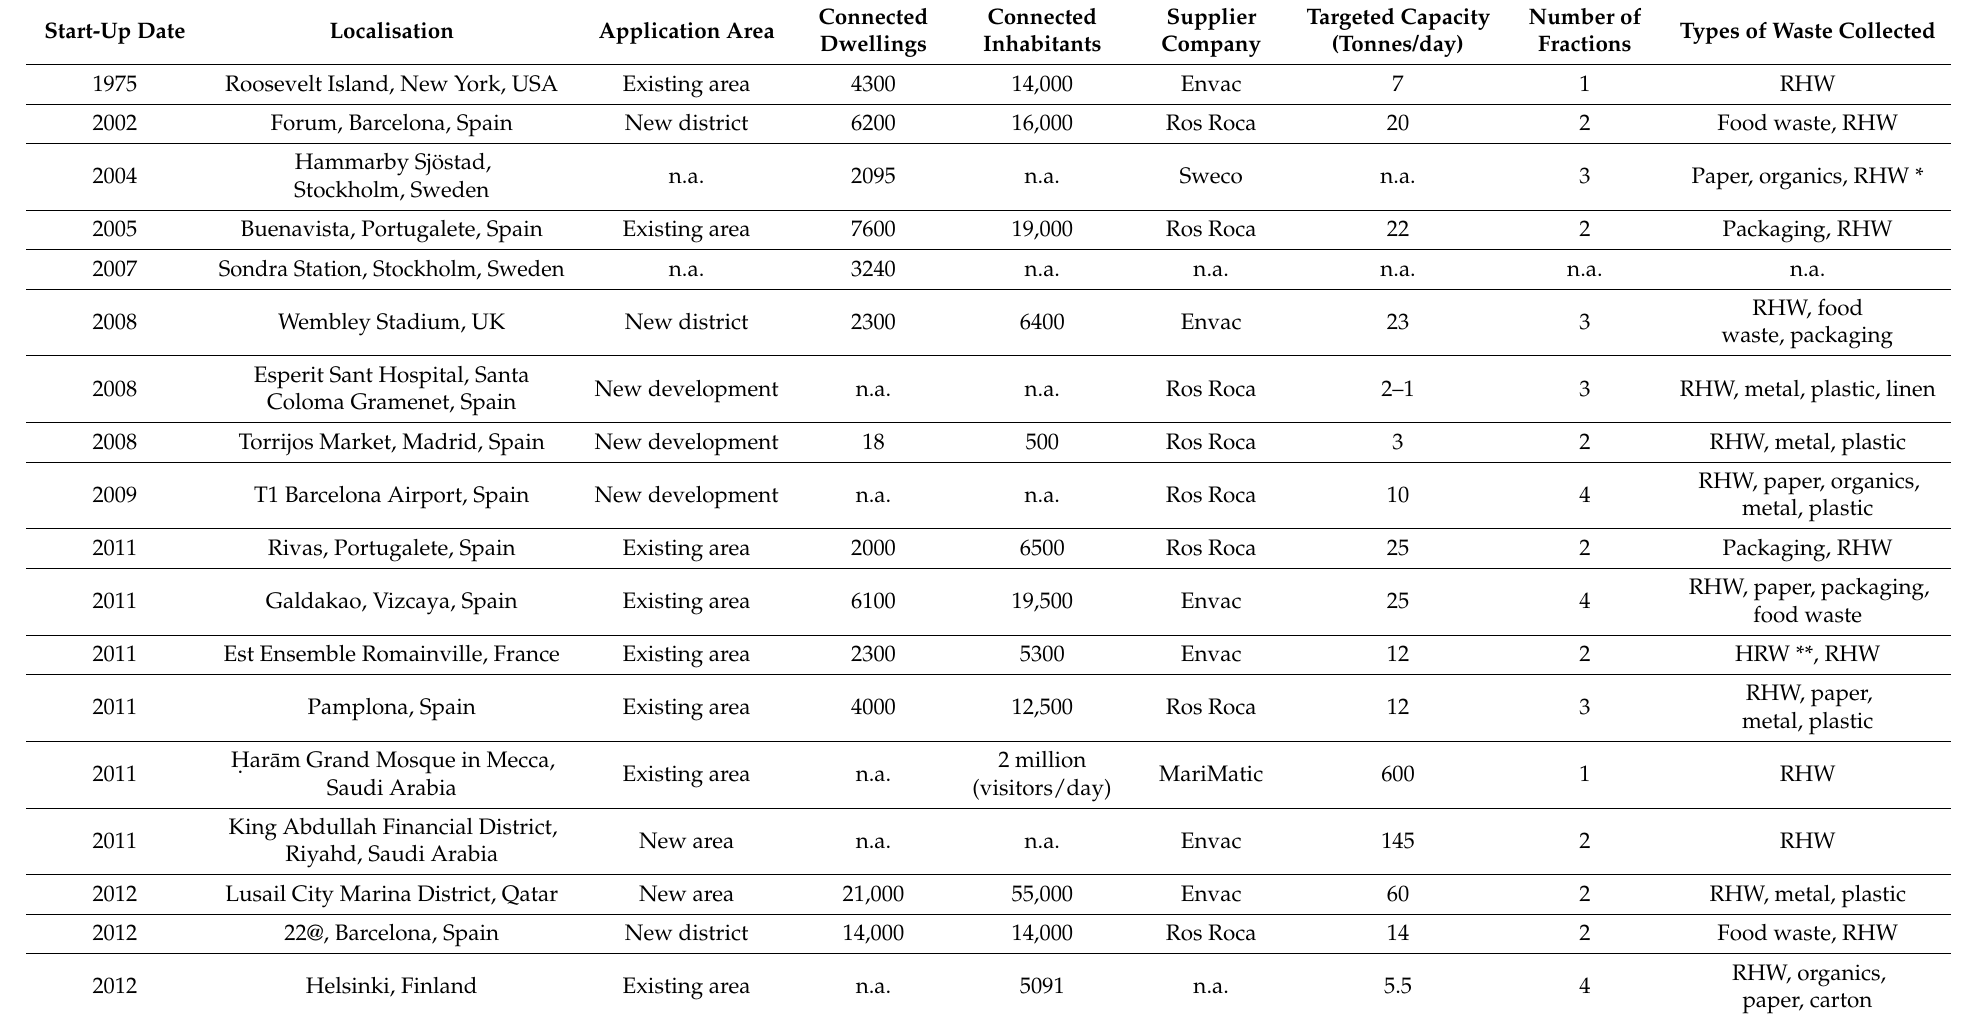
Table 1. Representative commercial vacuum waste collection systems. Based on [22] and completed by the